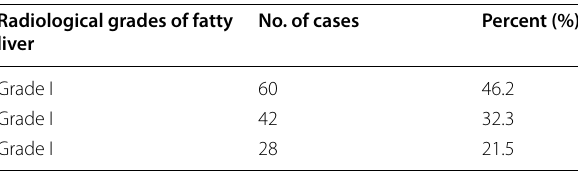
Table 3 Radiological grade of fatty liver among the studied patients ( N =